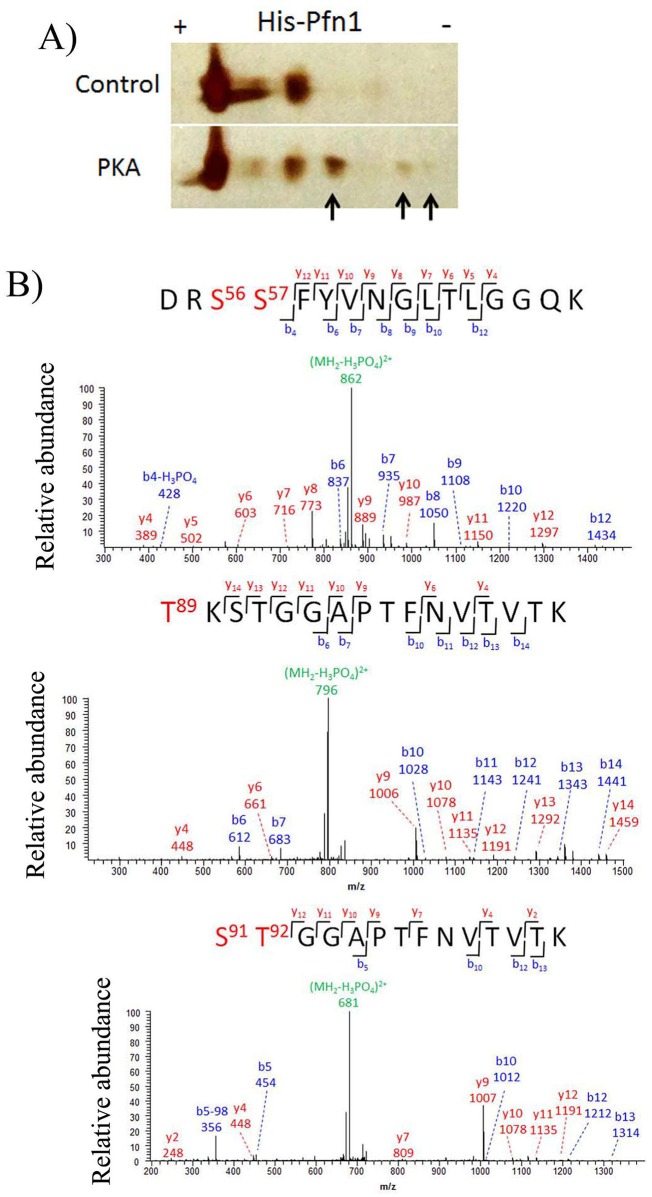
Pfn1 can be phosphorylated by PKA on multiple residues.A) His-tagged Pfn1 was treated with buffer containing ATP with or without PKA followed by 2D electrophoresis and visualized by silver staining (isoelectric focusing was conducted using a pH 4–7 IPG strip). Phosphorylation spots are marked by arrows. B) Mass-spectrometry based detection of phosphopeptides from PKA-treated His-Pfn1 reveled Pfn1 phosphorylation on three residues (S56/S57, T89, and S91/T92).